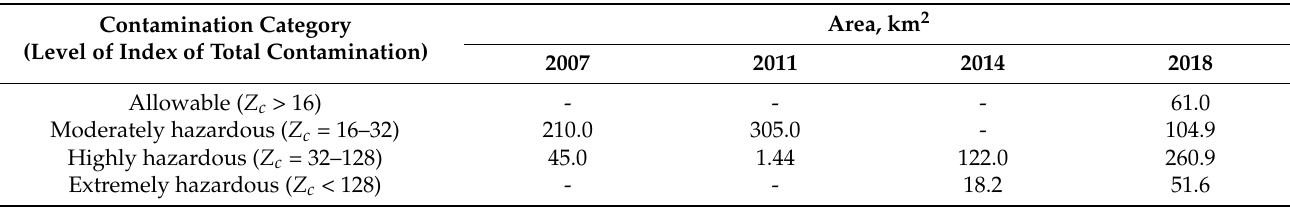
Table 5. Changes in the levels of multi-element contamination of the soil cover on the study territory over the years of